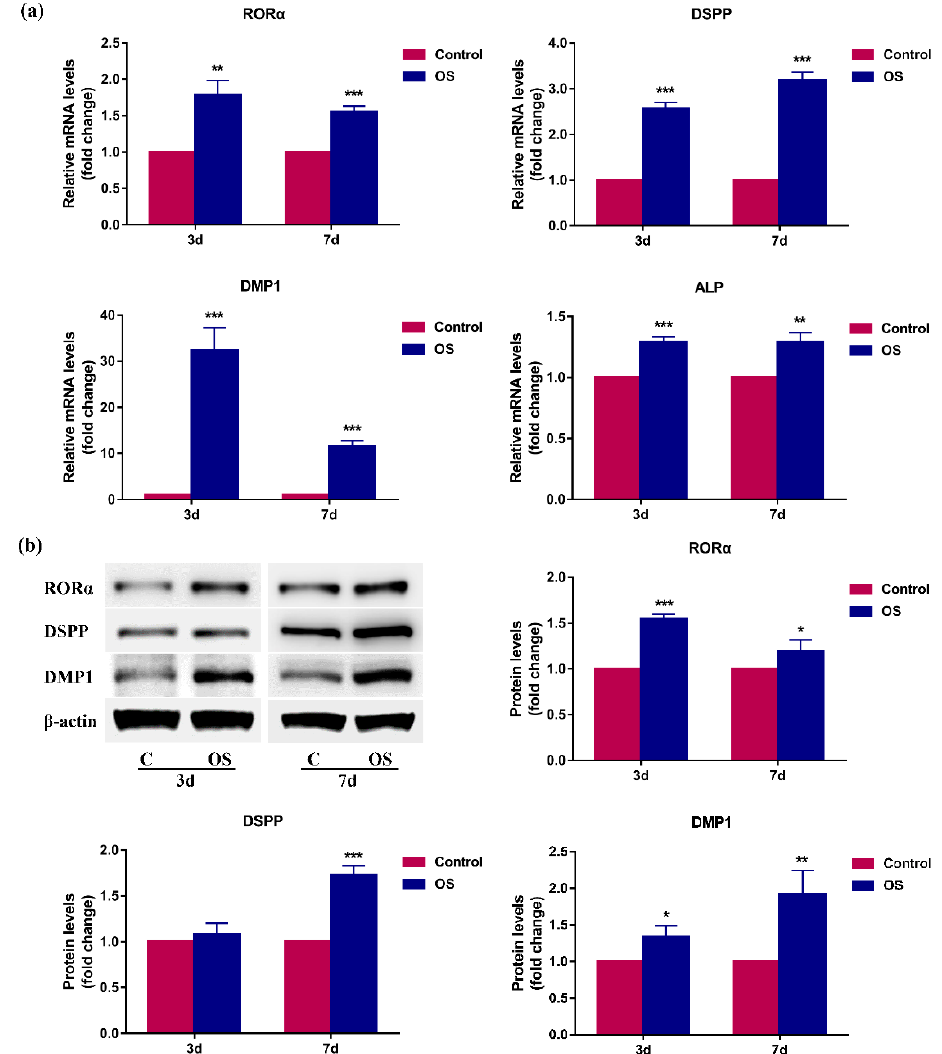
Figure 2. The expression pattern of retinoid acid receptor-related orphan receptor α (ROR α ) and odontogenic markers in rat dental papilla cells (rDPCs) during odontoblastic differentiation. rDPCs were cultured in maintained medium (control) or odontogenic induction medium (OS) for 3 and 7 days (3d and 7d), respectively. ( a ) The mRNA levels of ROR α , dentin sialophosphoprotein (DSPP), dentin matrix protein 1 (DMP1), and alkaline phosphatase (ALP) were quantified by quantitative reverse transcription polymerase chain reaction (qRT-PCR). Glyceraldehyde-3-phosphate dehydroge- nase (GAPDH) was used as the normalisation control; ( b ) The protein levels of ROR α , DSPP, and DMP1 were determined by western blotting and normalised to the protein level of β -actin. All data are presented as the mean ± SD ( n = 3). * p < 0.05, ** p < 0.01, *** p < 0.001 vs. Control